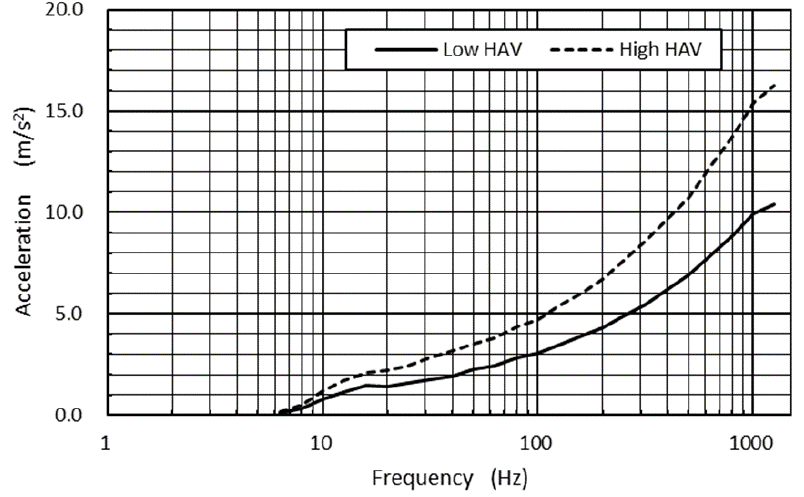
Figure 1. Spectra of pseudorandom vibrational signals used in this study.